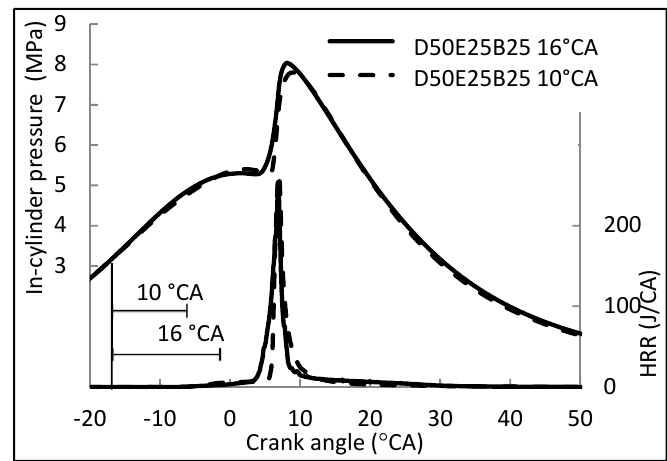
Figure 9. In-cylinder pressure and HRR graph of D50E25B25 blend against crank angle by using different injection durations.